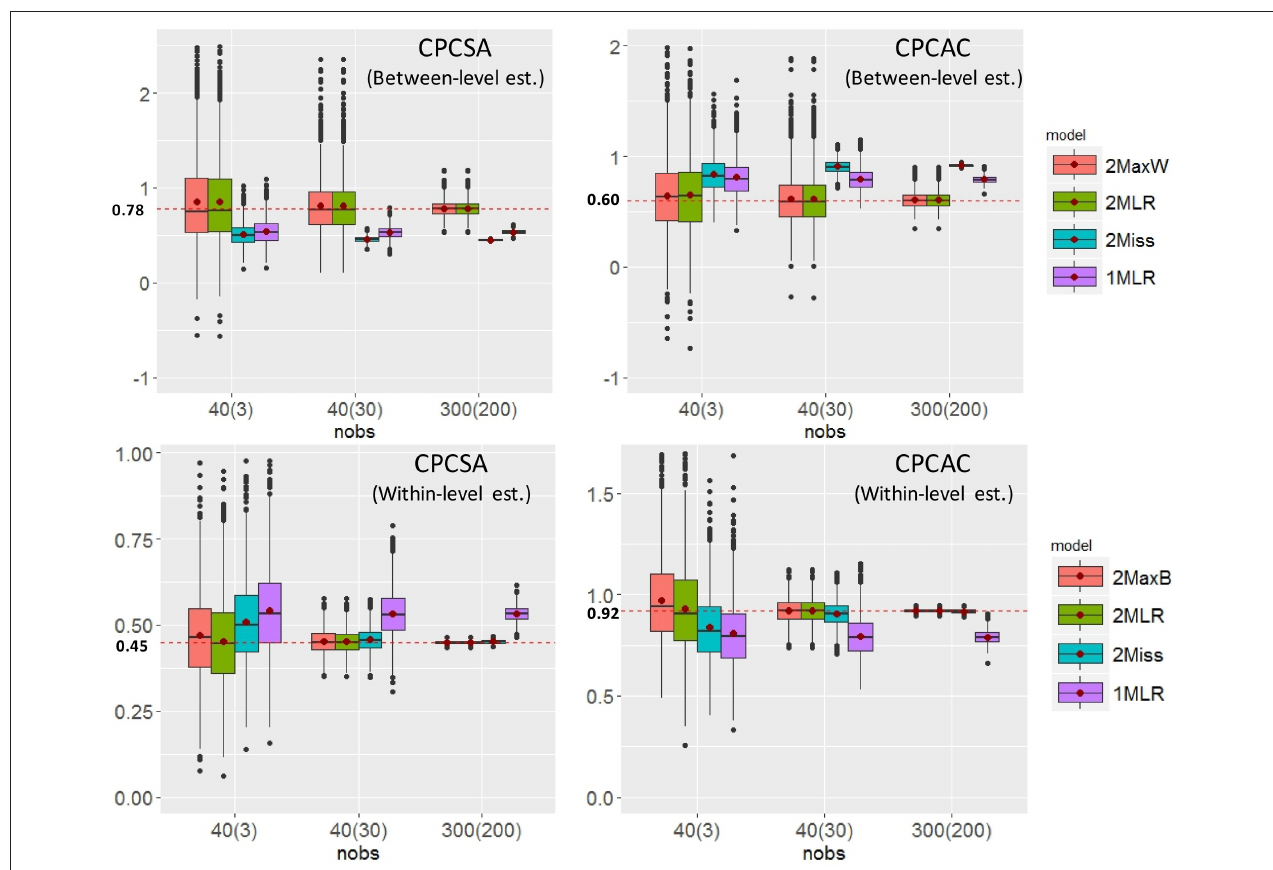
FIGURE 4 | The Boxplots of selected factor loading estimates vs. sample size conditions. The red dots in the boxes indicate the means of factor loading estimates. The red dashed lines indicates the parameter settings in respective levels.